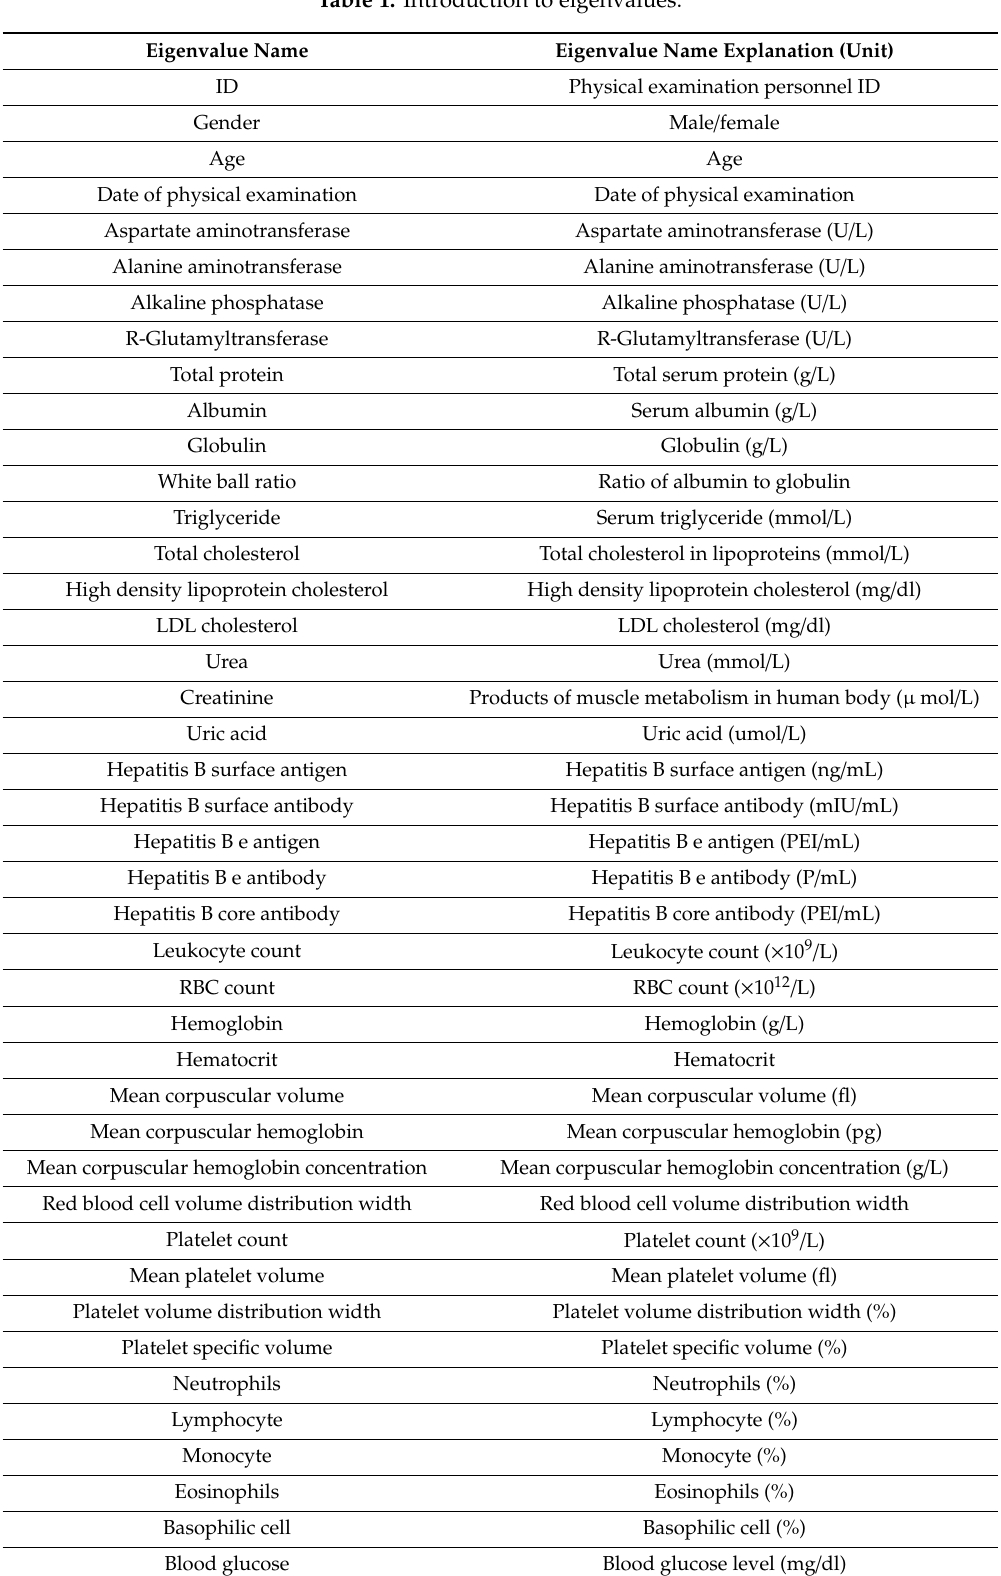
Table 1. Introduction to